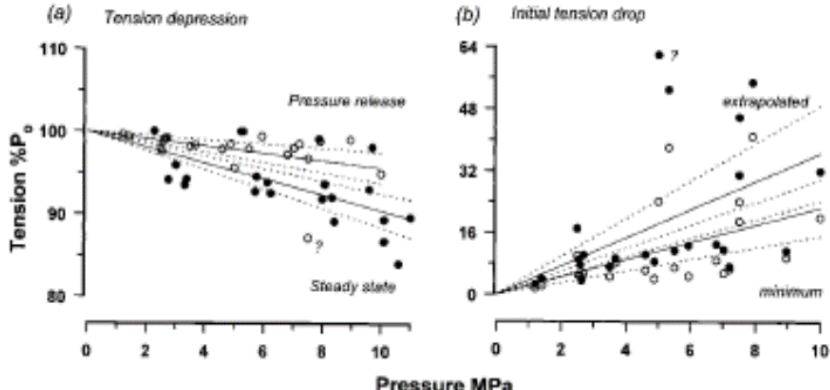
Figure 17. Pressure sensitivity of tension components: abscissa is the hydrostatic pressure to which a fibre was exposed prior to the release. ( a ) Filled circles: tetanic tensions measured from contrac- tions at different pressures (the solid line is the fitted linear regression and the dotted lines — 95% confidence envelope, p < 0.01, n = 21). The tension depression is 0.96% per MPa. Open circles: the steady tetanic tension level (high-pressure tension) prior to release is plotted as a percentage of the steady tension level (atmospheric) reached after the release. The linear regression fitted to the data, constrained to pass through 100% tension at zero MPa, is 0.44%/MPa. ( b ) The initial tension drop (P 1 ), plotted as a percentage of the recovered (atmospheric) tetanic tension. Open circles are the values measured from tension records and filled circles show the tension drop estimated by curve fitting. The tension drop is significantly correlated ( p < 0.05) and is 2.25% per MPa for measured and 3.35% per MPa for the extrapolated (the extreme high value, labelled with a question mark was excluded in both ( a , b )).